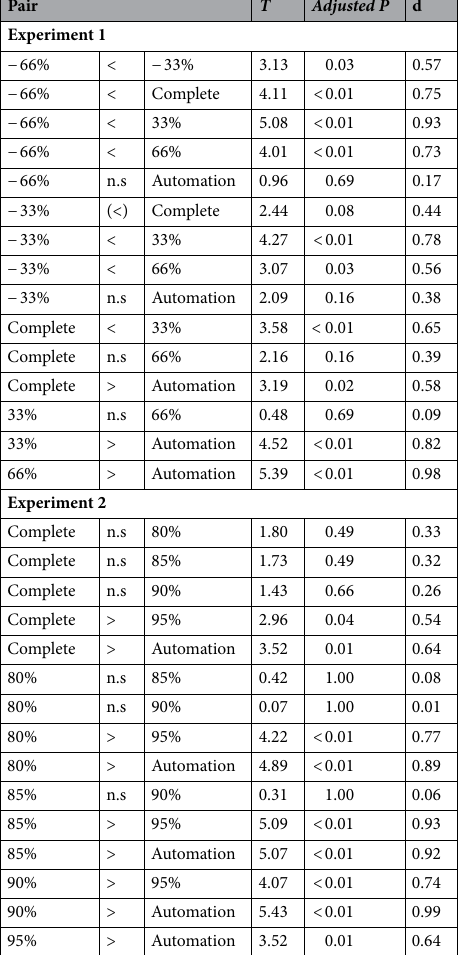
Table 1. Multiple comparison using Shaffer’s modified sequentially rejective Bonferroni procedure: Control